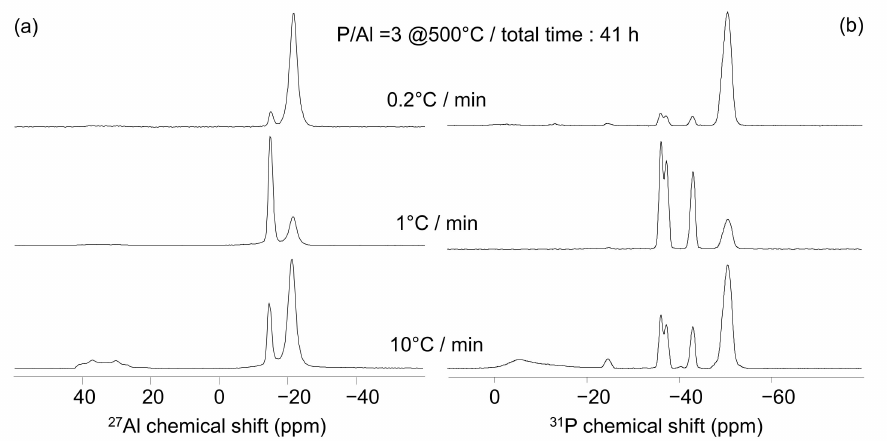
Figure 6. 27 Al ( a ) and 31 P ( b ) MAS-NMR spectra obtained at 500 ◦ C on the P/Al = 3 solution with 10 ◦ C/(bottom), 1 ◦ C (middle), and 0.2 ◦ C (top)/min heating rate. The dwell times are different and lead to a similar total treatment time of 41 h for the three